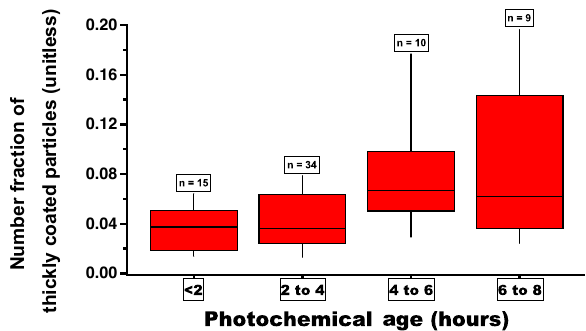
Figure 8. Number fraction of rBC particles that are thickly coated ( f ) vs. photochemical age (PCA) for the hours of 13:00 to 16:00. Boxes depict the 25th and 75th percentiles, whiskers depict the 10th and 90th percentile, and the horizontal lines within the boxes show the median. The text boxes indicate the number of data points in each